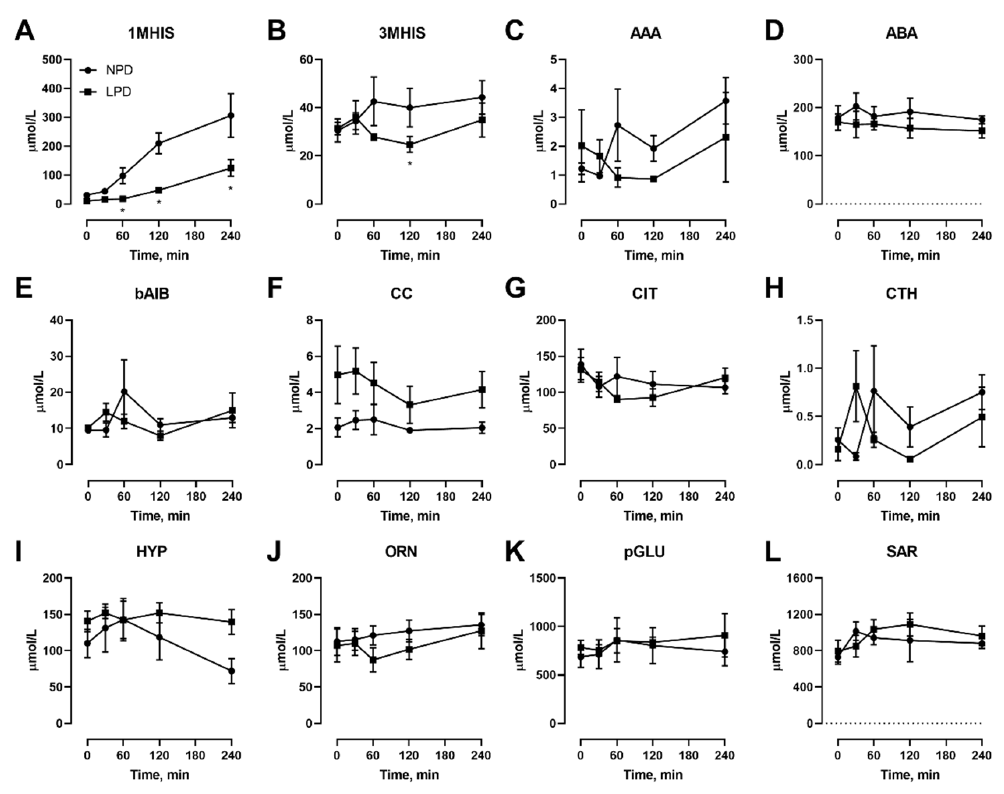
Figure 5. E ff ects of dietary protein restriction on blood serum non-proteinogenic amino acids during isocaloric meal feeding. Young men ( n = 5) underwent a 7 d period of consuming a protein-restricted diet, with isocaloric meal tolerance tests conducted before and at the end of the 7 d period, with blood samples drawn at selected time points during the test. Blood serum amino acid levels including 1-methyl histidine ( A ), 3-methyl histidine ( B ), α -aminoadipate ( C ), α -aminobutyrate ( D ), β -aminoisobutyrate ( E ), cystine ( F ), citrulline ( G ), cystathionine ( H ), hydroxyproline ( I ), ornithine ( J ), pyroglutamate ( K ) and sarcosine ( L ) were measured. NPD: normal-protein diet; LPD: low-protein diet. Data are the mean ± SEM. Two-way RM ANOVA, di ff erent than NPD: * p < 0.05.